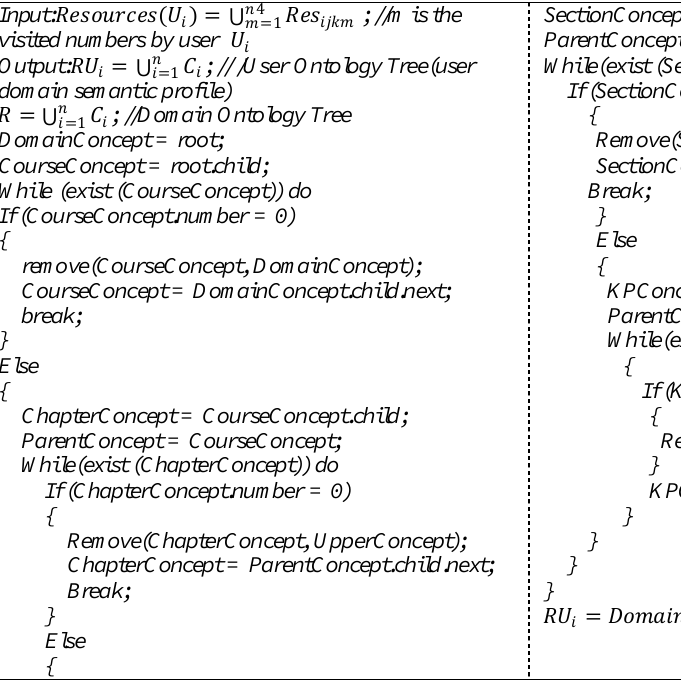
algorithm 2 indicates the construction process of the